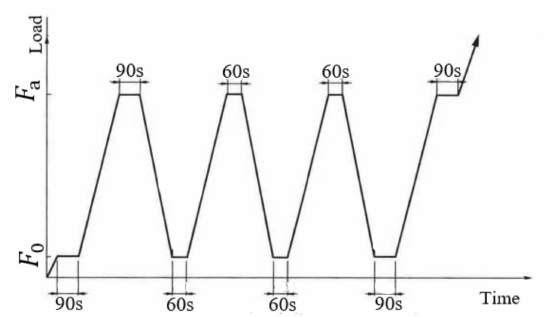
Figure 6. The loading process of